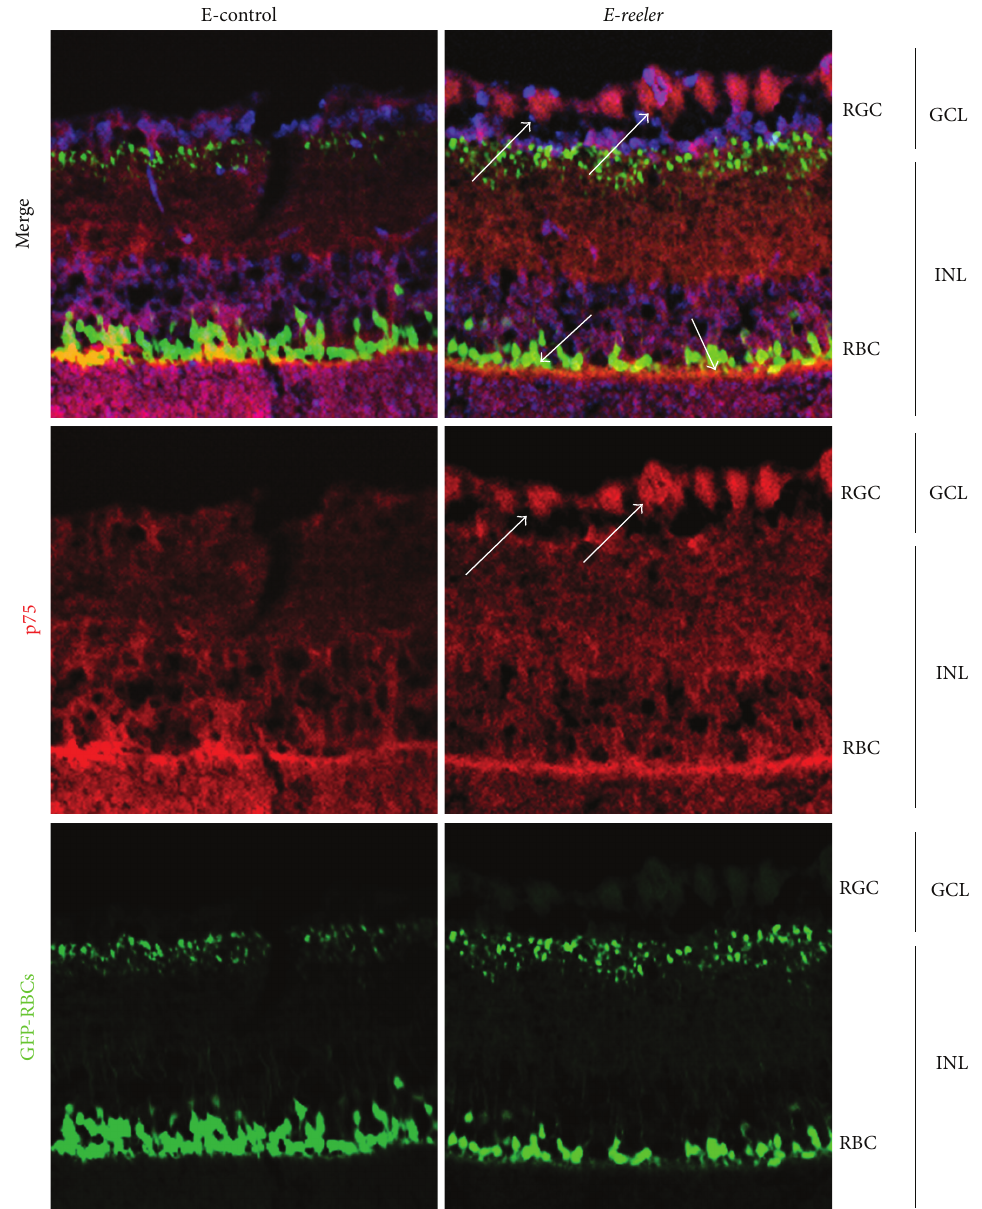
Figure 4: p 75 NTR localization in E-reeler retina. Confocal microscopy showing images of GFP-expressing RBCs (green), p 75 NTR immunoreactivity (red), and nuclear staining (blue). Arrows point to a noticeable staining of RGCs, RBCs, and accessories/glial cells localized in the GCL/INL of E-reeler retina. Note the intense cytoplasmatic p 75 NTR localization in both RGCs and RBCs. Abbreviations: GFP, Green Fluorescet Protein; GCL, Ganglion Cell Layer; INL, Inner Nuclear Layer; RGCs, Retinal Ganglion Cells; RBCs, Rod Bipolar Cells ( ×